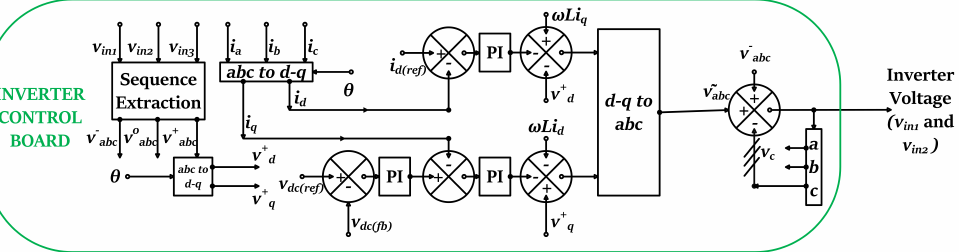
Figure 6. Proposed control embedded in inverter control